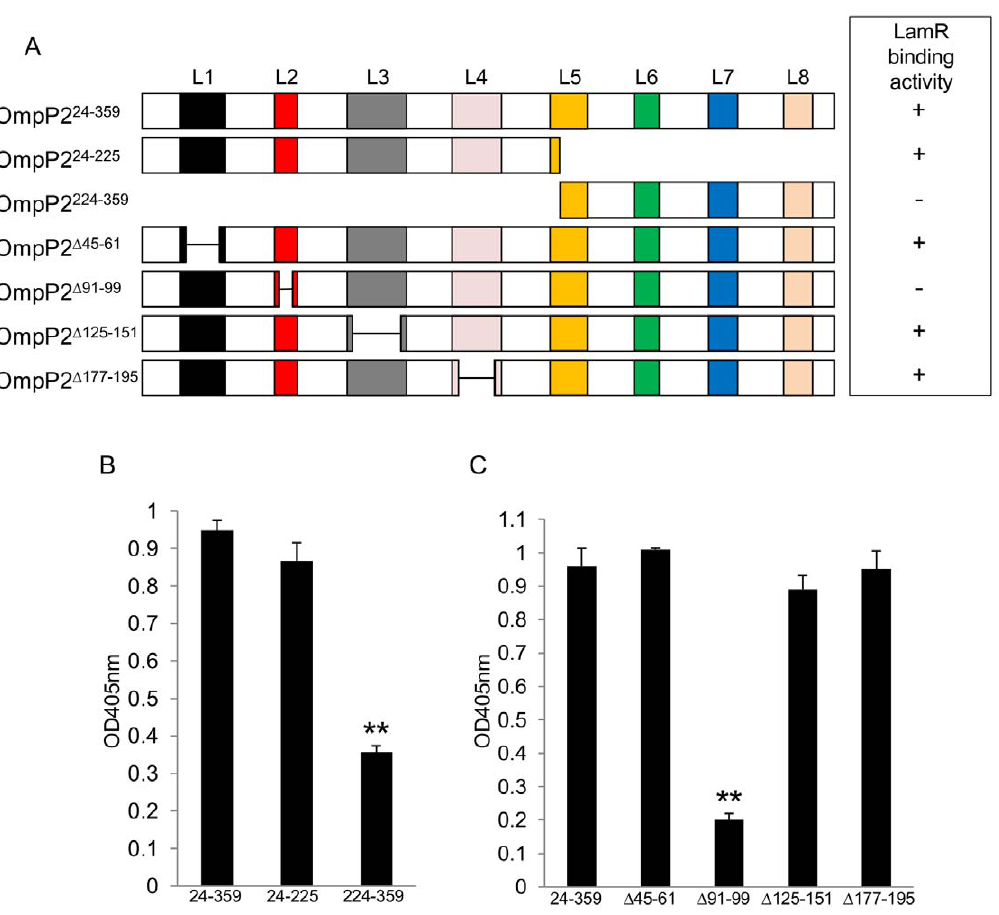
Figure 2. Amino acids 91–99 of recombinant OmpP2 exhibit LamR-binding activity. (A) Schematic showing the recombinant derivatives of H. influenzae Rd KW20 OmpP2 utilized in this study and a summary of their respective LamR-binding activities. L1–L8 denotes the eight extra-cellular loops based on the model of Srikumar et al. [24]. (B) Binding of LamR to the solid phase antigens OmpP2 24–359 , OmpP2 24–225 OmpP2 224–359 . (C) Binding of LamR to OmpP2 24–359 , OmpP2 D 45–61 , OmpP2 D 91–99 , OmpP2 D 125–151 and OmpP2 D 177–195 . Data shown in each panel are means from three independent experiments; in each experiment each sample was tested in triplicate. ** p , 0.01 compared to binding with matching OmpP2 24–359 samples. Error bars indicate